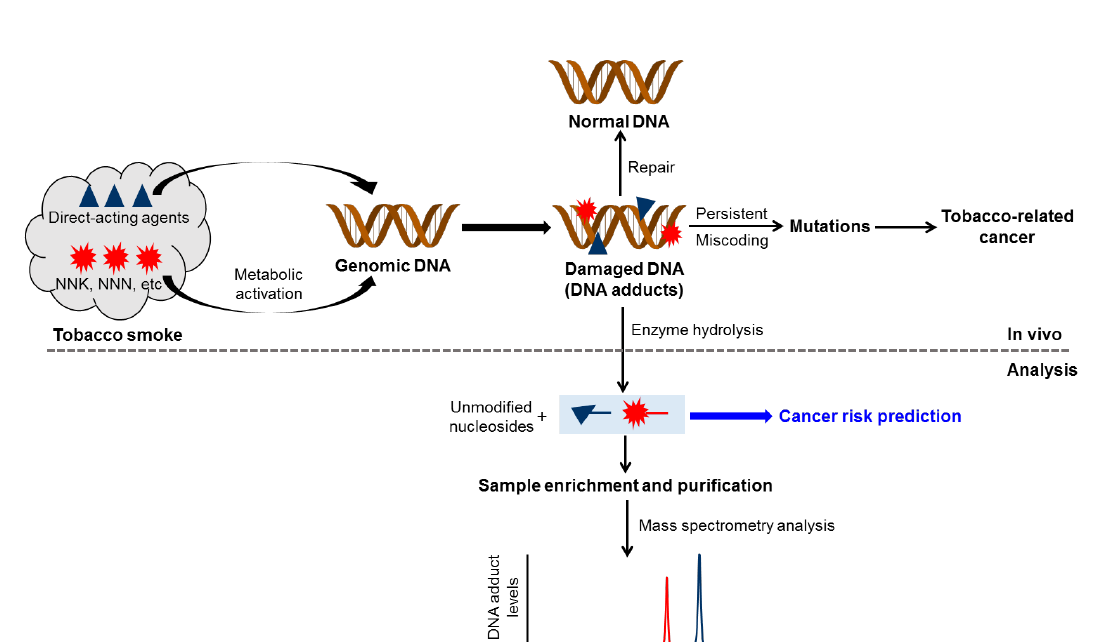
Figure 1. An overview of the central role of DNA adduct formation in tobacco-related cancer. DNA damage also leads to cell apoptosis. A more detailed mechanistic framework was illustrated by Hecht S.S. [13].